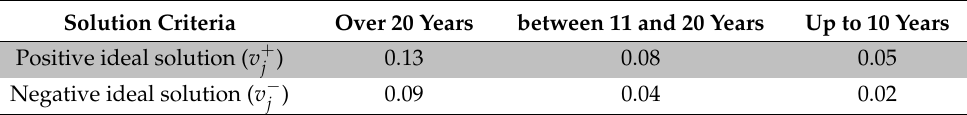
Table 5. Positive ideal solution and negative ideal solution for accessing the criteria. Source: authors. Solution